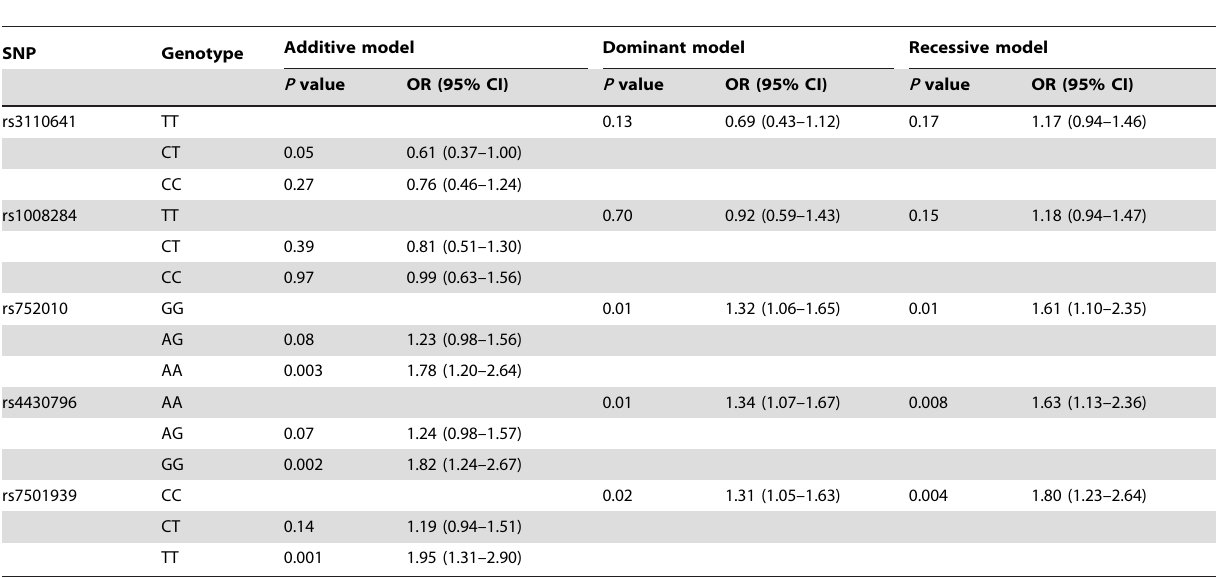
Table 3. Effects of TCF2 genotypes on the risk of type 2 diabetes under different genetic